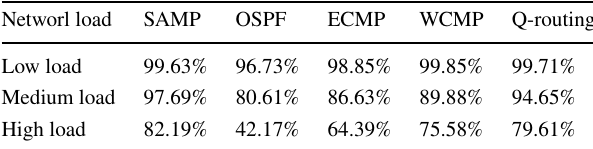
Table 1 Transmission success rate in static network load Networl load